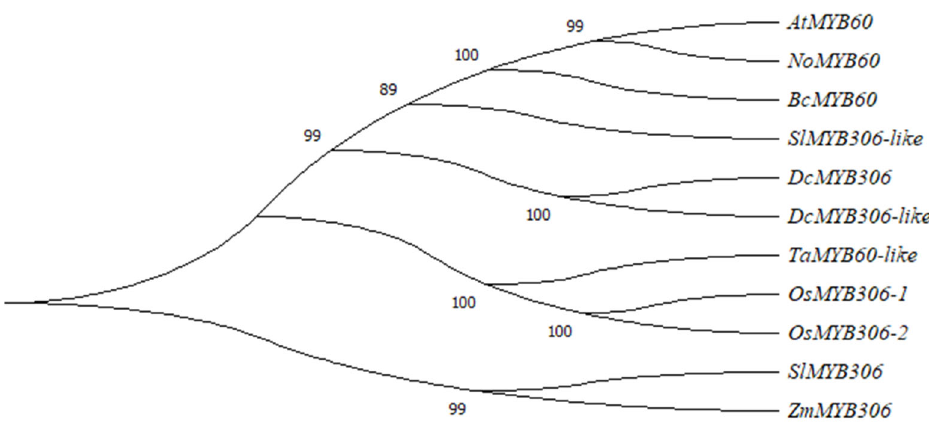
Figure 2. Phylogenetic analysis of MYB60 genes in different species. The phylogenetic tree of MYB60 was constructed by MEGA7.0, including Arabidopsis (At), pak choi (Bc), N. officinale (No), O. sativa (Os), Z. mays (Zm), S. lycopersicum (Sl), D. carota (Dc) and T. aestivum (Ta).